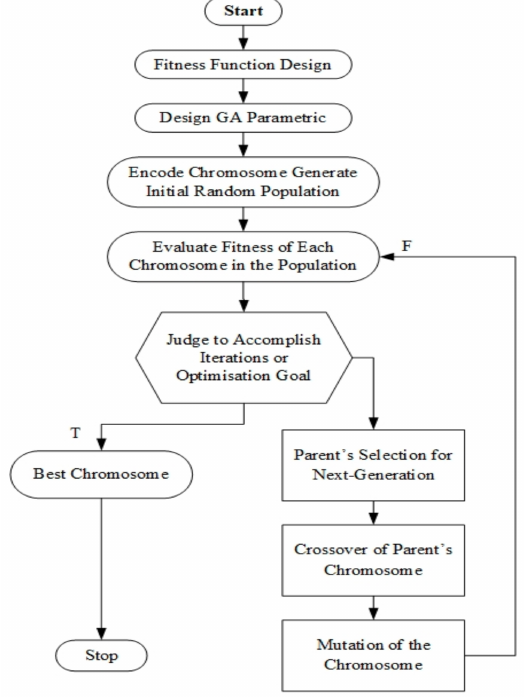
Figure 9. Displayed the flow chart of Gene Evolution Algorithm (GEA) procedure of PV array